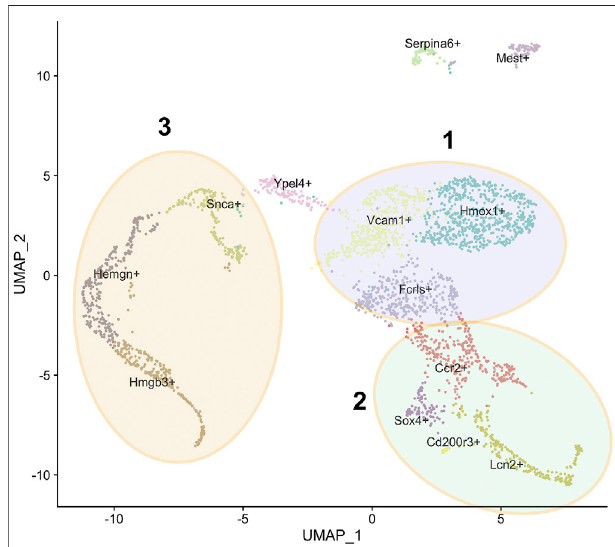
FIGURE1| SubpopulationsofF4/80+macrophagesfromE13.5mouse fetal liver. U-MAP clustering analysis of single cell RNA-Seq data from Mukherjee et al. (2021) showing the 13 subpopulations with the name of a unique marker for each subpopulation superimposed on it. Three superclusters are as indicated, based on GO analysis of highly expressed genesasdescribedinthetext:theHmox1+,Vcam1+,Fcrls+supercluster1in blue, the Ccr2+, Lcn2+, Sox4+ supercluster 2 in green, and the Snca+, Hemgn+, Hmgb3+ supercluster 3 in yellow.